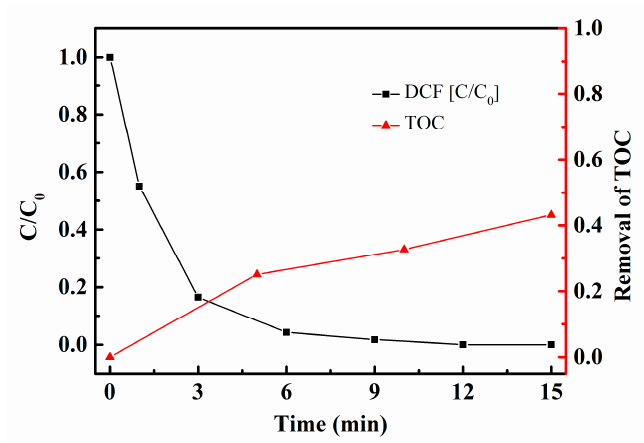
Figure 8. The photodegradation of DCF and the TOC removal during the reaction. [DCF] = 1 mg L − 1 , [Ag 3 PO 4 /g-C 3 N 4 (30%)] = 0.1 g L − 1 .